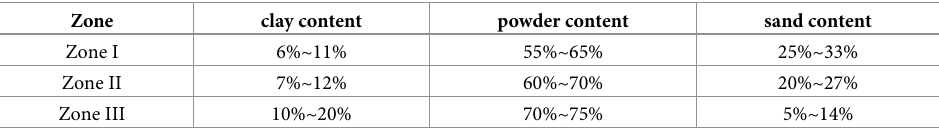
Table 2. Particle gradation components of selected the sampling